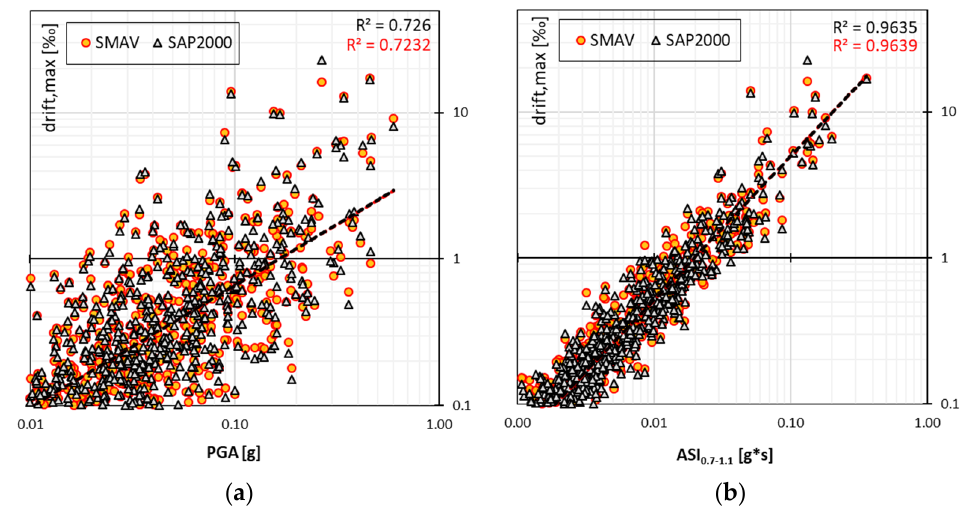
Figure 9. Detail of the Maximum Drift Ratios comparison in ( a ) PGA and ( b ) ASI scale.